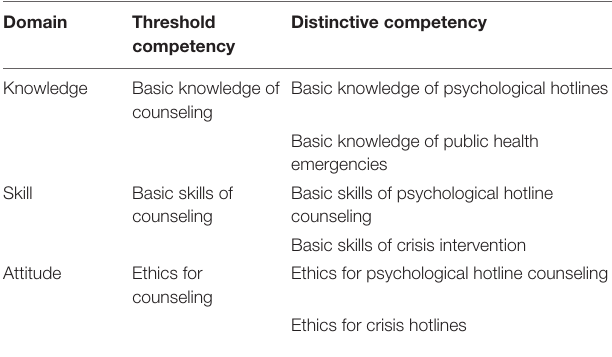
TABLE 1 | The primary construct of the competence model for psychological hotline